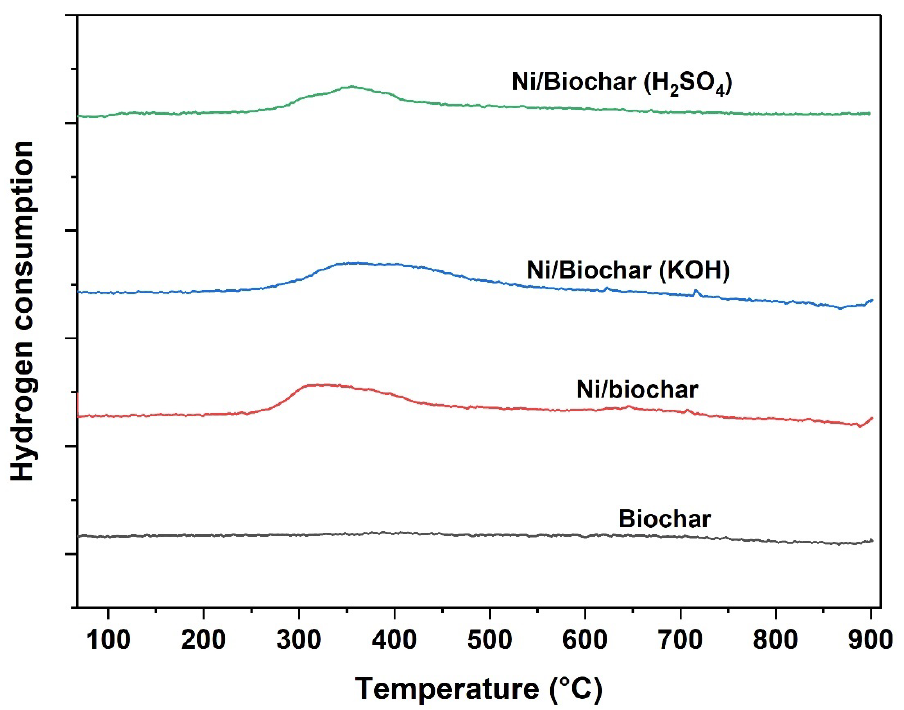
Figure 6. H 2 -TPR profiles of raw biochar, Ni/biochar, Ni/biochar (KOH), and Ni/biochar (H 2 SO 4 ) catalysts.